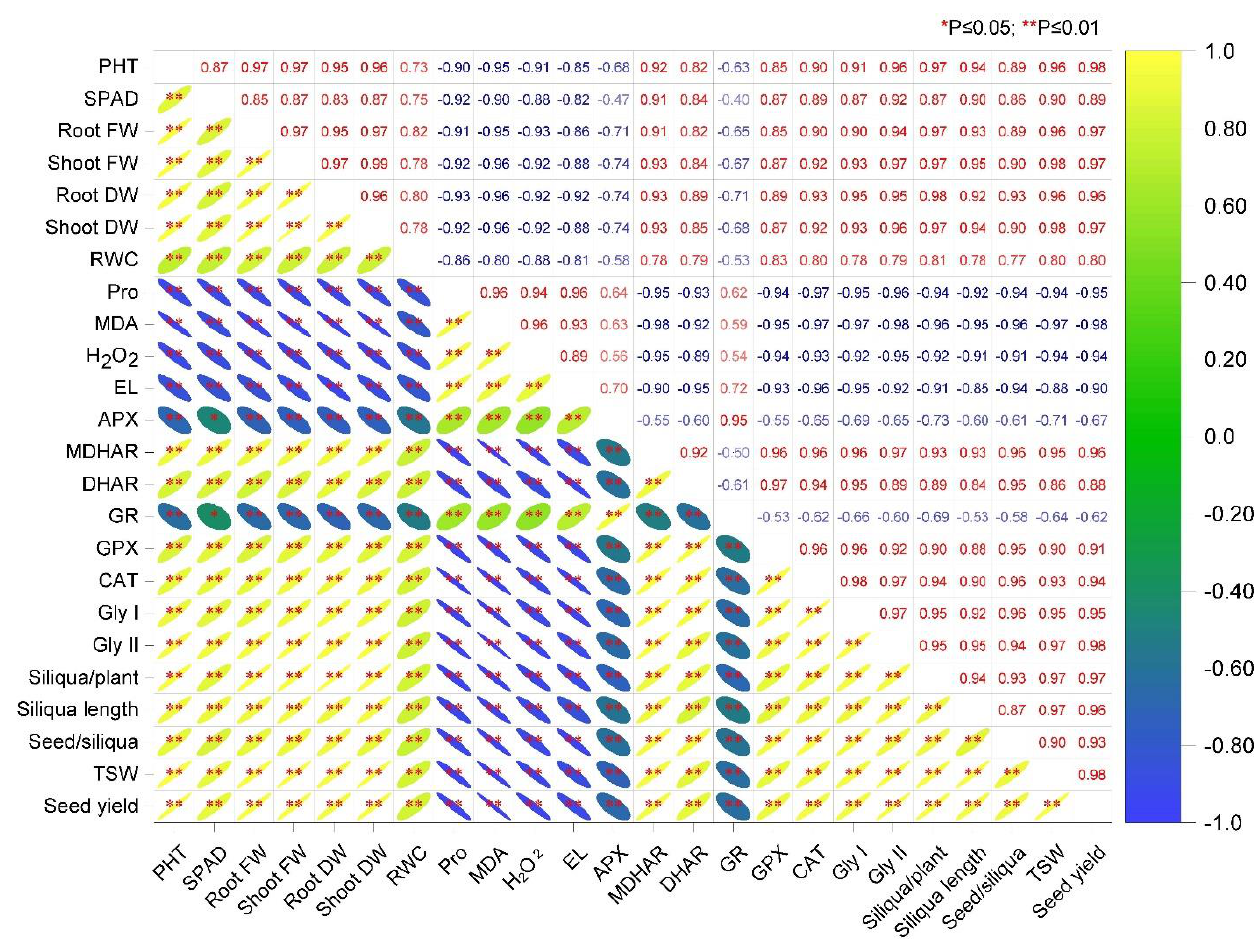
Figure 8. Correlation matrix among the different parameters of rapeseed as affected cadmium stress.